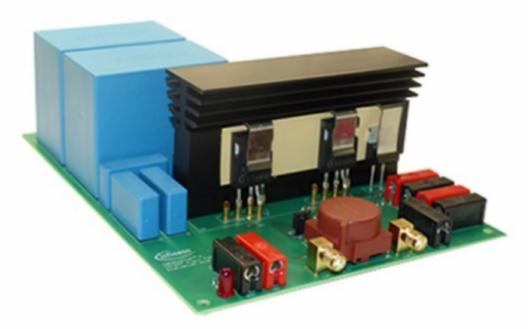
Figure 3. The test platform [8].